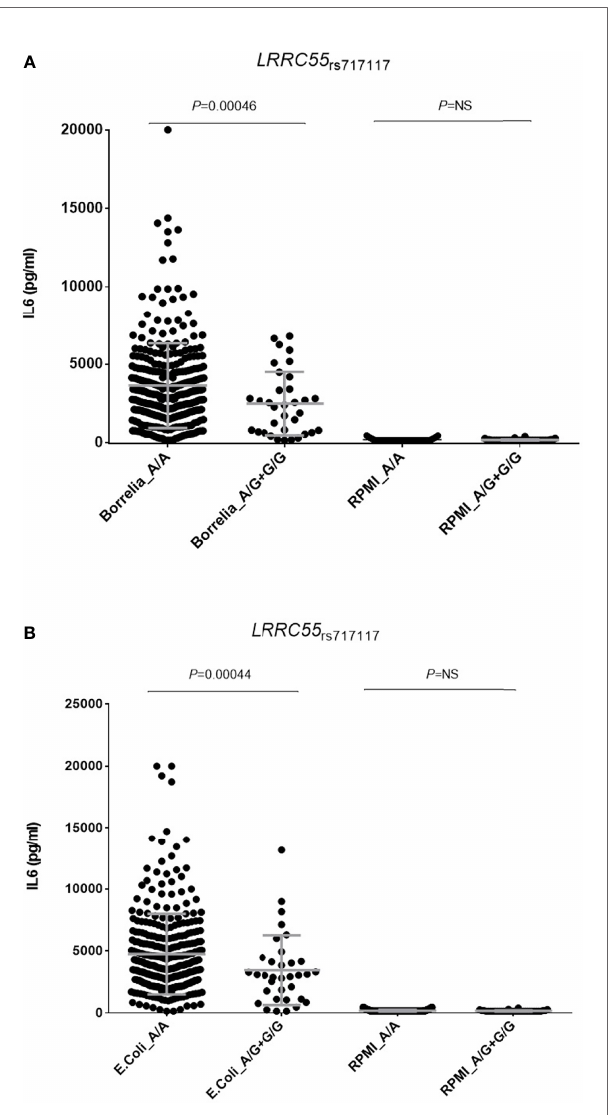
FIGURE 2 | Correlation of the LRRC55 rs717117G allele and levels of IL6 after stimulation of PBMCs either with B. burgdorferi (A) or E. coli (B)